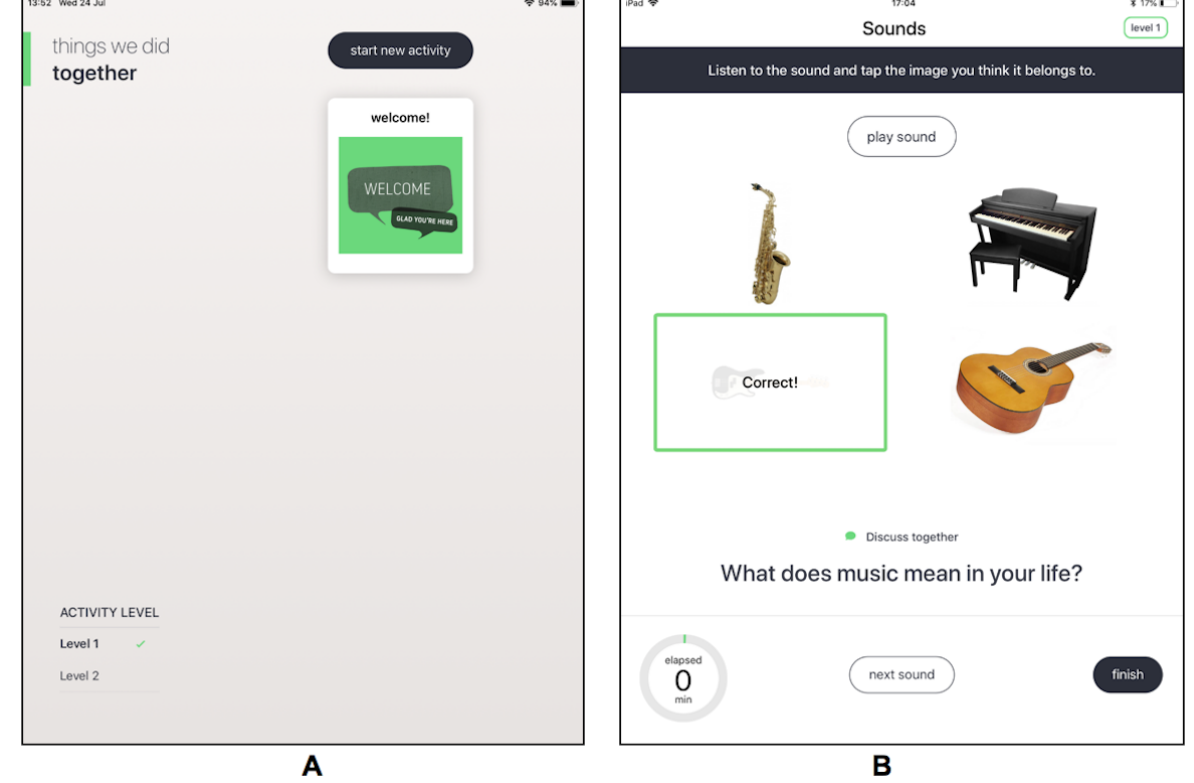
Figure 2. Screenshots of the individual cognitive stimulation therapy app. A. home screen and B. sounds